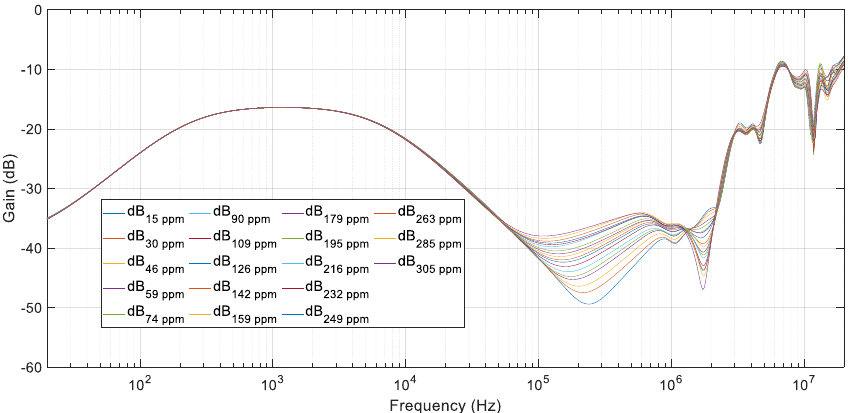
Figure 13. FRA test results from 15 ppm up to 305 ppm of salt in water.